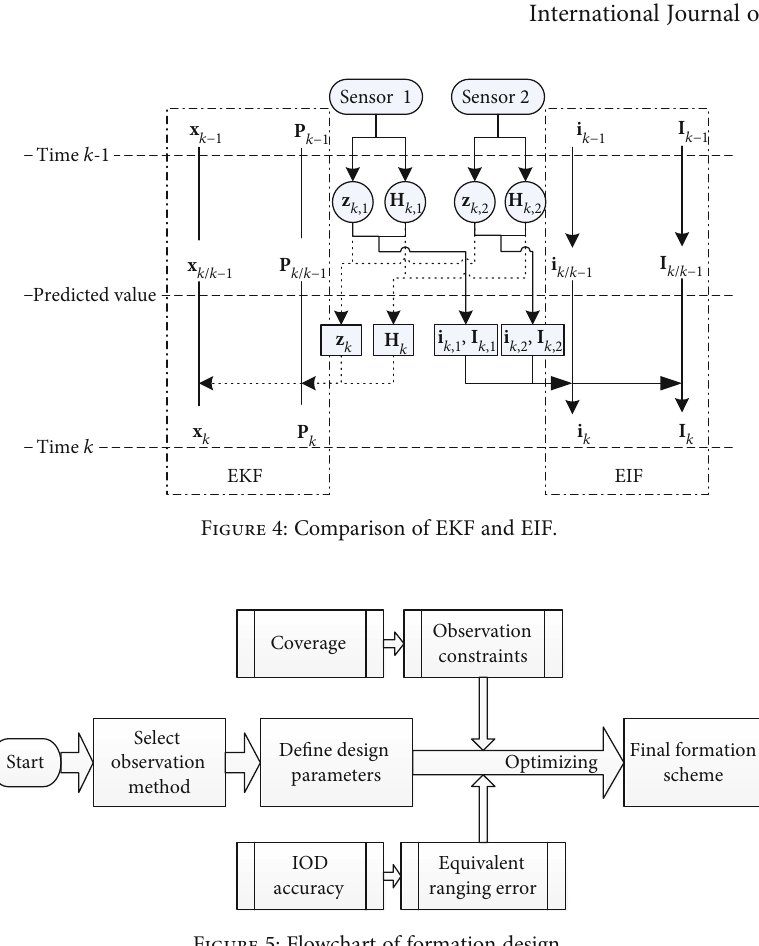
Figure 5: Flowchart of formation